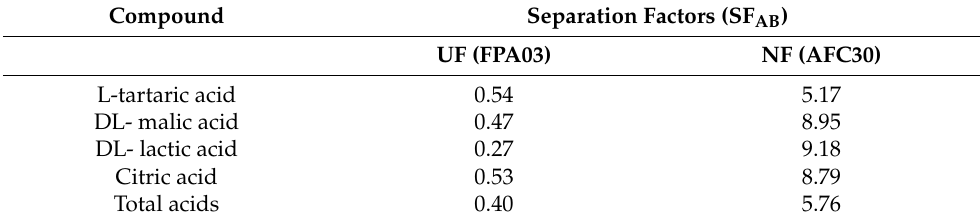
Table 5. Separation factors (average, n =